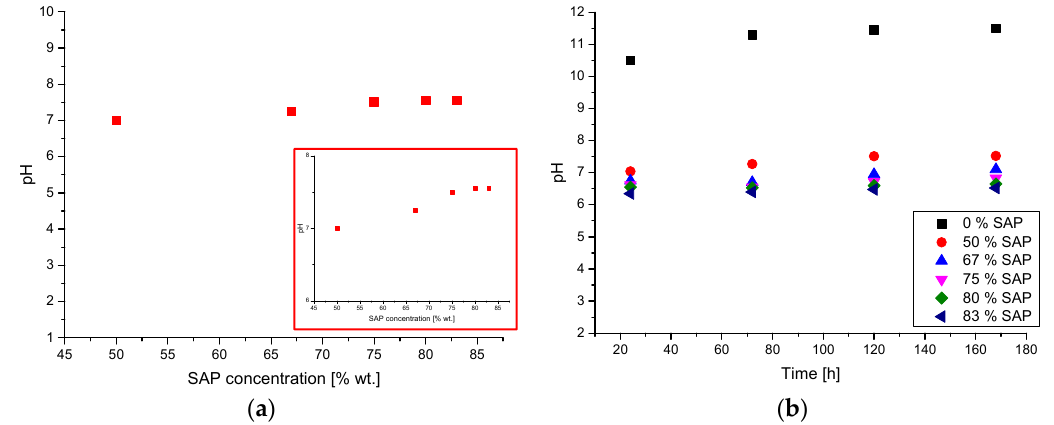
Figure 10. Changes in the pH values of BaTiO 3 suspensions as a function of SAP concentrations ( a ) and incubation time ( b ).